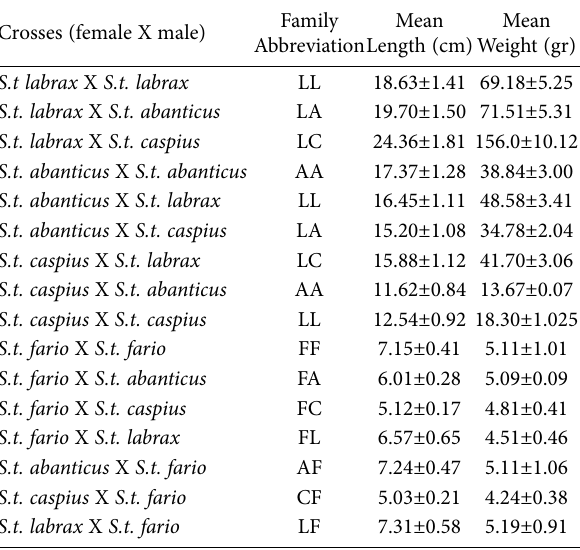
Table 1. Cross-types of fish and their abbreviation, mean length and